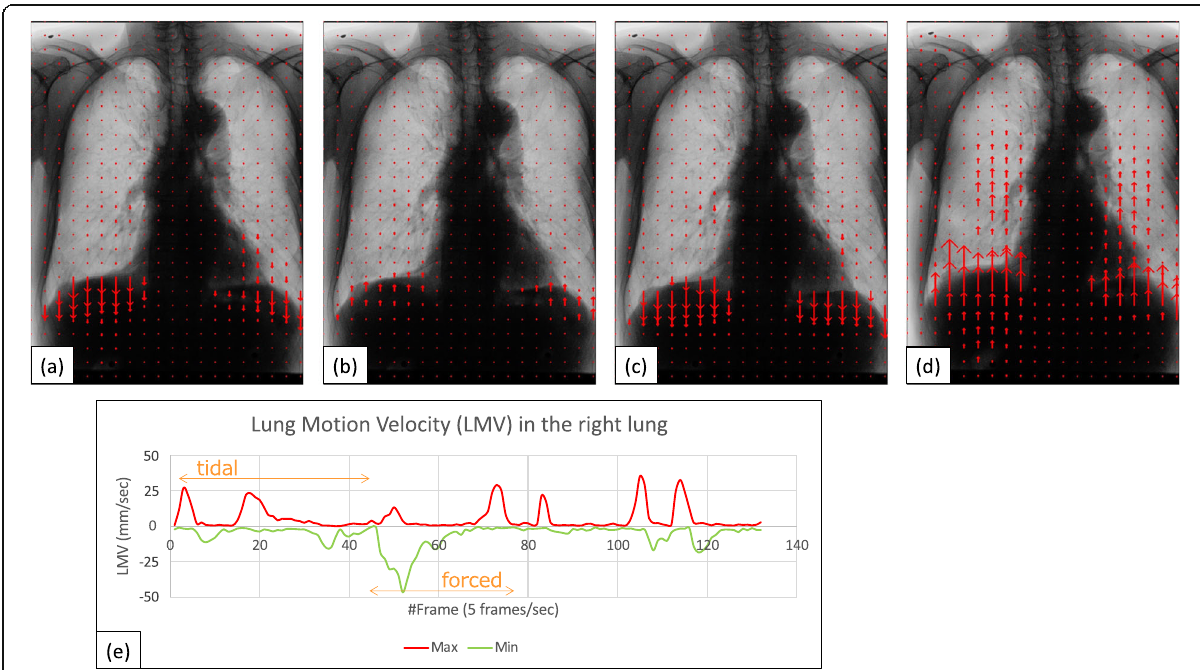
Fig. 3 A 53-year-old made, COPD patient with FEV 1 % 60.3 and %FEV 1 79.6, which meets the criteria of GOLD 2, COPD mild group. VF-DXR images: ( a ) tidal inspiratory, ( b ) tidal expiratory, ( c ) forced inspiratory, and ( d ) forced expiratory phase. The graph ( e ) shows the temporal change between LMV in the right lung and the number of frames. The frame rate is set to 5 frames/s. COPD Chronic obstructive pulmonary disease, FEV 1 % Forced expiratory volume percent in one second divided by forced vital capacity, % FEV 1 Percent predicted forced expiratory volume in one second, GOLD Global initiative for chronic obstructive lung disease, LMV Lung motion velocity, VF-DXR Vector-field dynamic